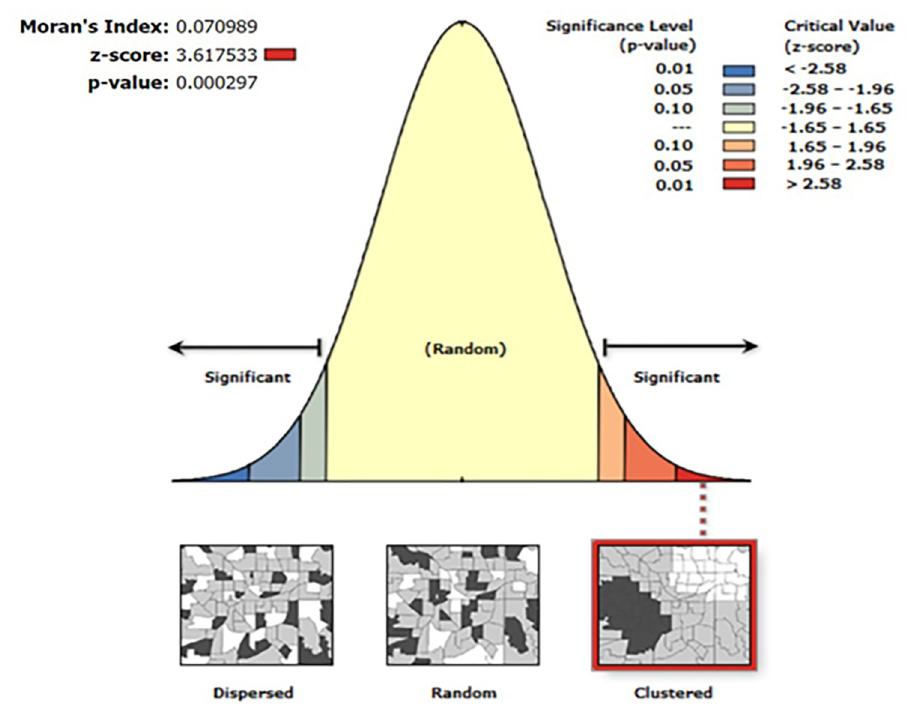
Fig 5. Spatial autocorrelation result of high-risk fertility behaviours among married women in the Democratic Republic of the Congo.